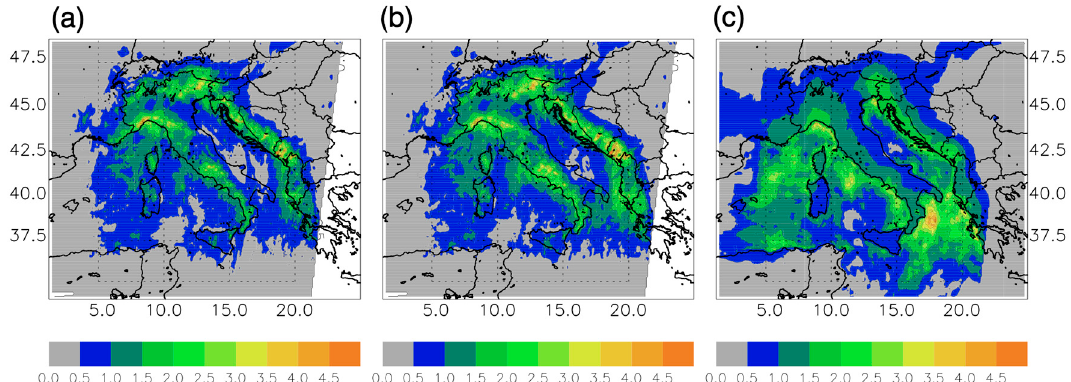
Figure 2. Mean precipitation over the month of November 2019 for ( a ) CTRL forecast, ( b ) LIGHT forecast, and ( c ) Integrated Multi-satellitE Retrievals for Global Precipitation Mission (IMERG).